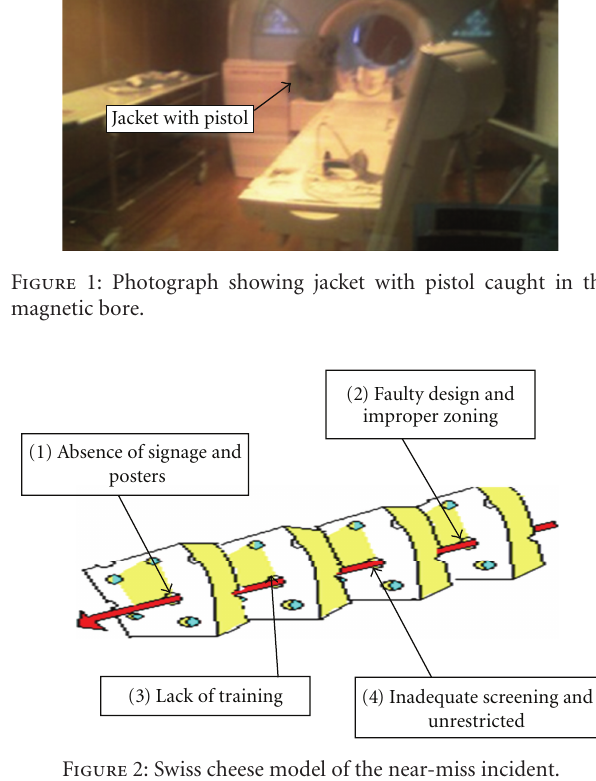
Figure 2: Swiss cheese model of the near-miss